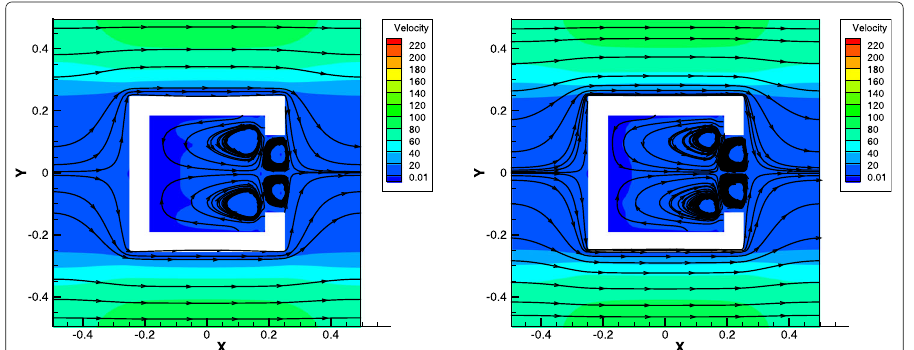
Fig. 11 The streamline and velocity magnitude of the micro flow through periodic square cylinders with Knudsen number Kn = 1.0 × 10 − 4 . Left figure shows UGKS solution and right figure shows the NS solution by GKS